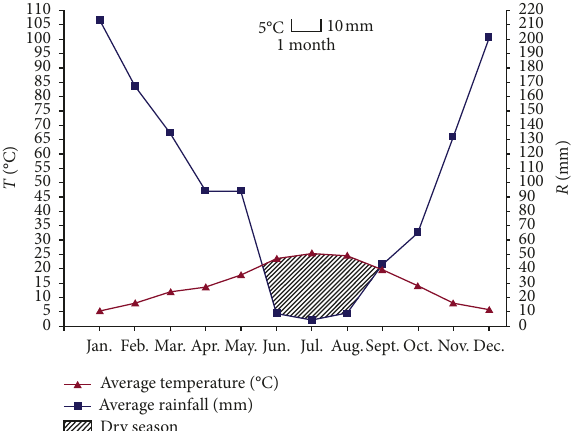
Figure 2: Ombrothermic diagram of Bagnouls and Gaussen of A.E.H. between 1998 and 2007.